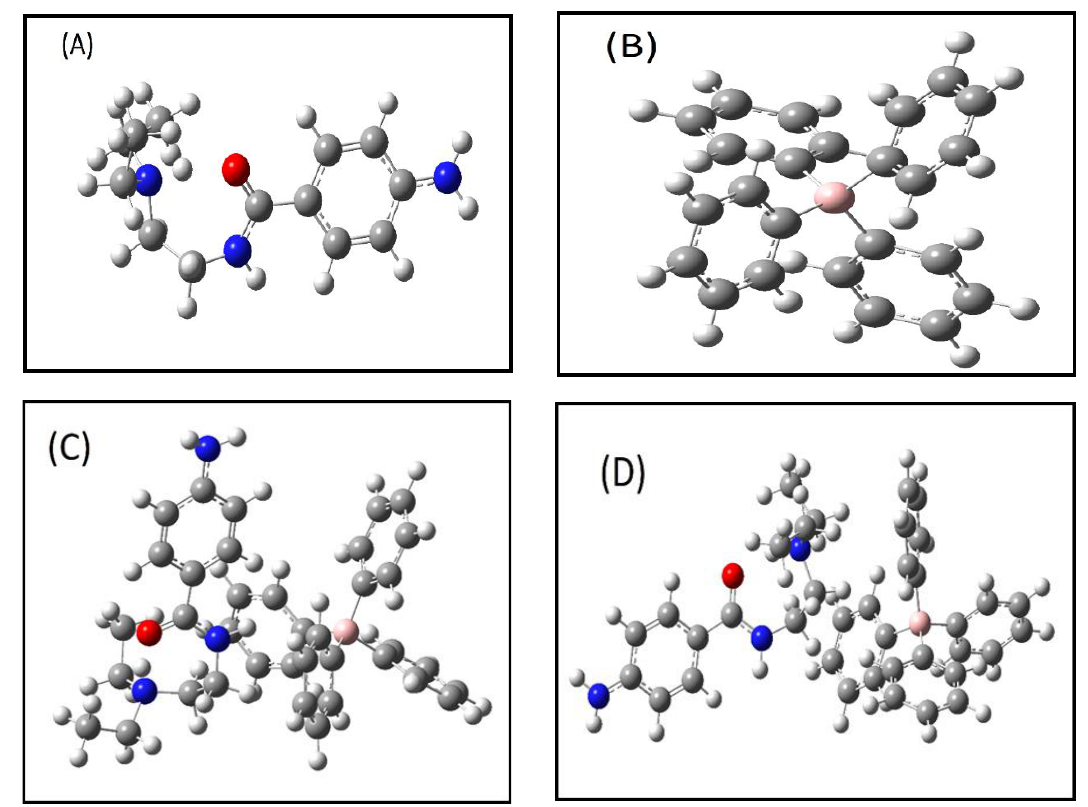
Figure 2. B3LYP/6-311G(d,p) optimized geometries of the molecules: ( A ) procainamide cation, ( B ) tetraphenylborate anion, ( C , D ) procainamide cation, and tetraphenylborate anion salt.